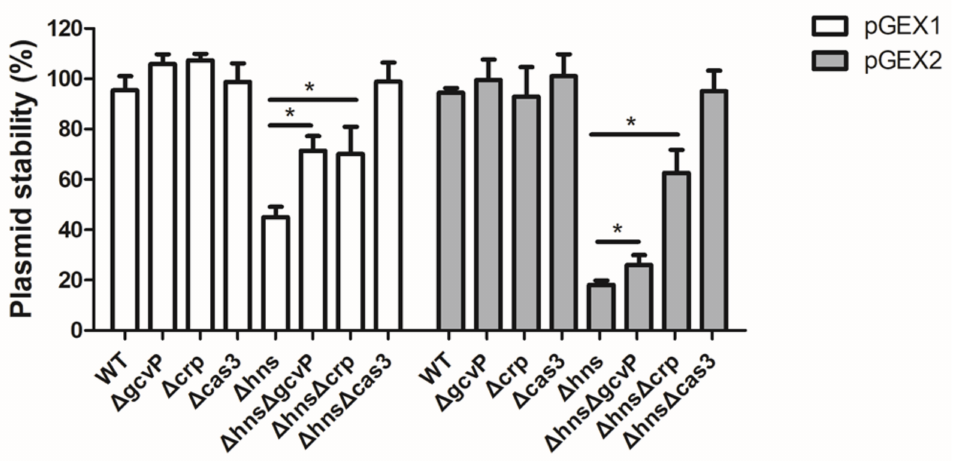
Figure 10. Mutation of gcvP or crp increases the stability of plasmids. The plasmids containing the CRISPR1 (pGEX1) or CRISPR2 (pGEX2) loci of MG1655 and the empty plasmids (pGEX) were transferred into WT, ∆ hns , ∆ hns ∆ gcvP , ∆ hns ∆ crp , and ∆ hns ∆ cas3 . The stability of the plasmid was determined by calculating the percentage of bacteria containing the pGEX1 or pGEX2 in the bacteria containing the pGEX plasmids. The transformation e ffi ciencies of both pGEX1 and pGEX2, which contain the spacer cloned from MG1655, were remarkably increased in ∆ hns ∆ gcvP , ∆ hns ∆ crp , and ∆ hns ∆ cas3 compared with ∆ hns . All the data were mean ± SEM of at least three replicates, and the p value (* p < 0.05) was analyzed by the t